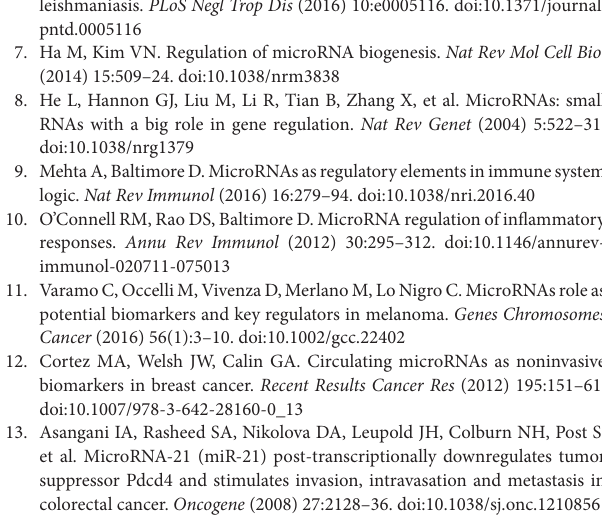
TaBle s1 | Demographic and clinical metadata from Leishmania braziliensis patients. TaBle s4 | Identification of known microRNAs after data refinement. TaBle s6 | Canonical pathways of the innate immune response that are significantly modulated in leishmaniasis as identified by Ingenuity Pathways Analysis.